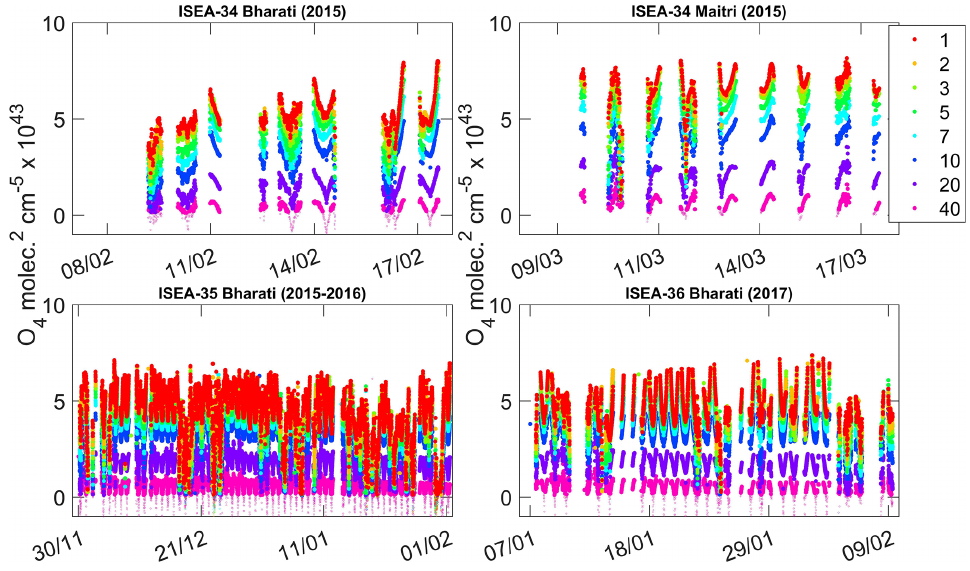
Figure 4. O 4 DSCDs observed during the four campaigns are shown. The empty circles represent values below the 2 σ detection limit of the instrument, while the filled circles are values above the 2 σ detection limit. The data are color-coded according to elevation angles.